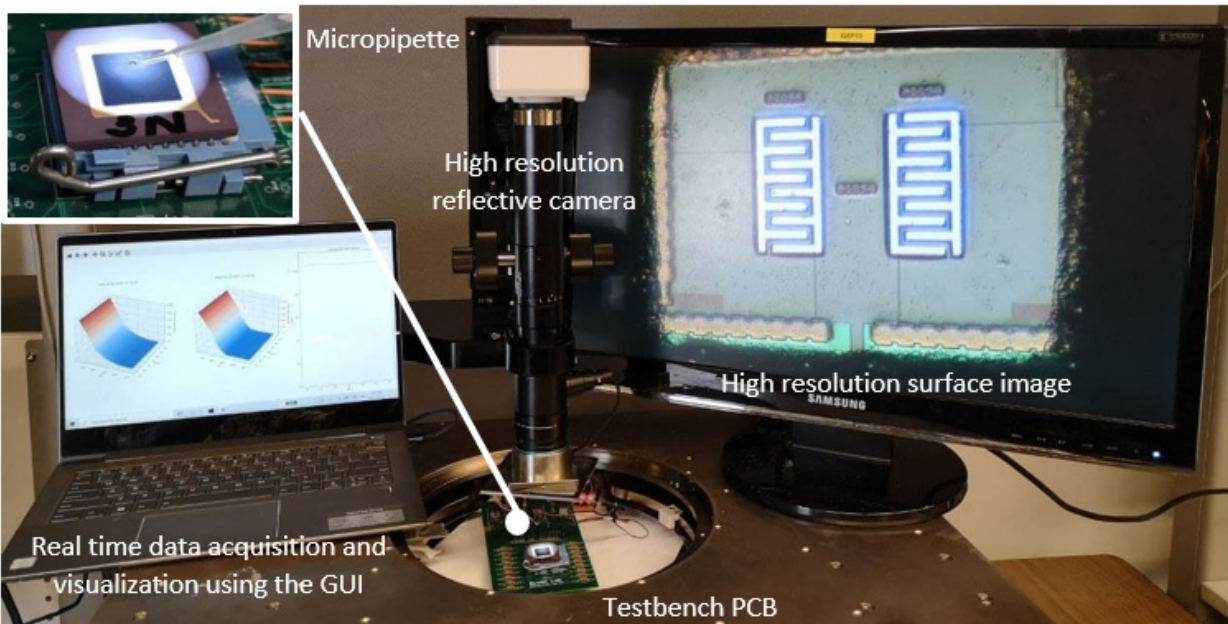
Figure 16. The prepared testbench for real-time data acquisition using the GUI and capturing images before and after cell experiments using the high-resolution reflective camera.